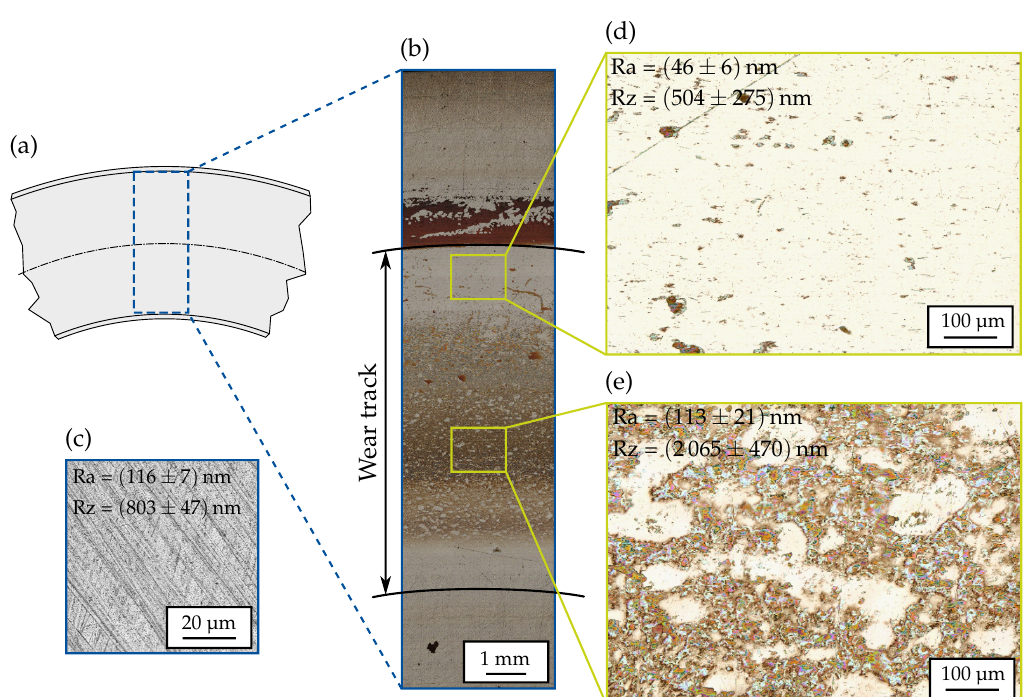
Figure 4. Damage analysis of the reference specimen Ref. 2 by 3D laser scanning microscope: ( a ) Principal section view of a bearing washer. ( b ) Wear track of the reference specimen after a test duration of 38 min. ( c ) Bearing washer in initial state with measured roughness parameters Ra and Rz . ( d , e ) High magnification microscopic view of the wear area with Ra and